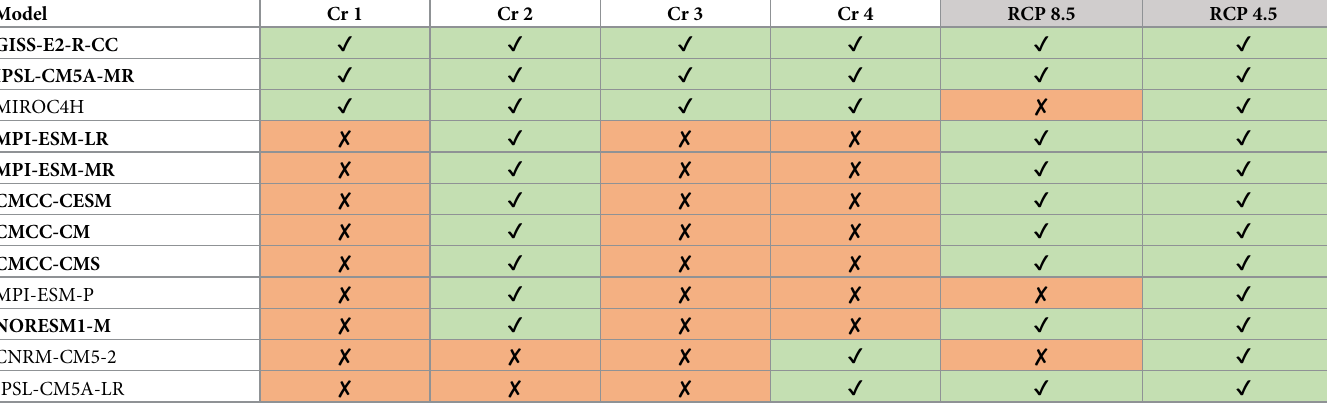
Criterion 3: Models with a reasonable representation of the spatial structure of the surface